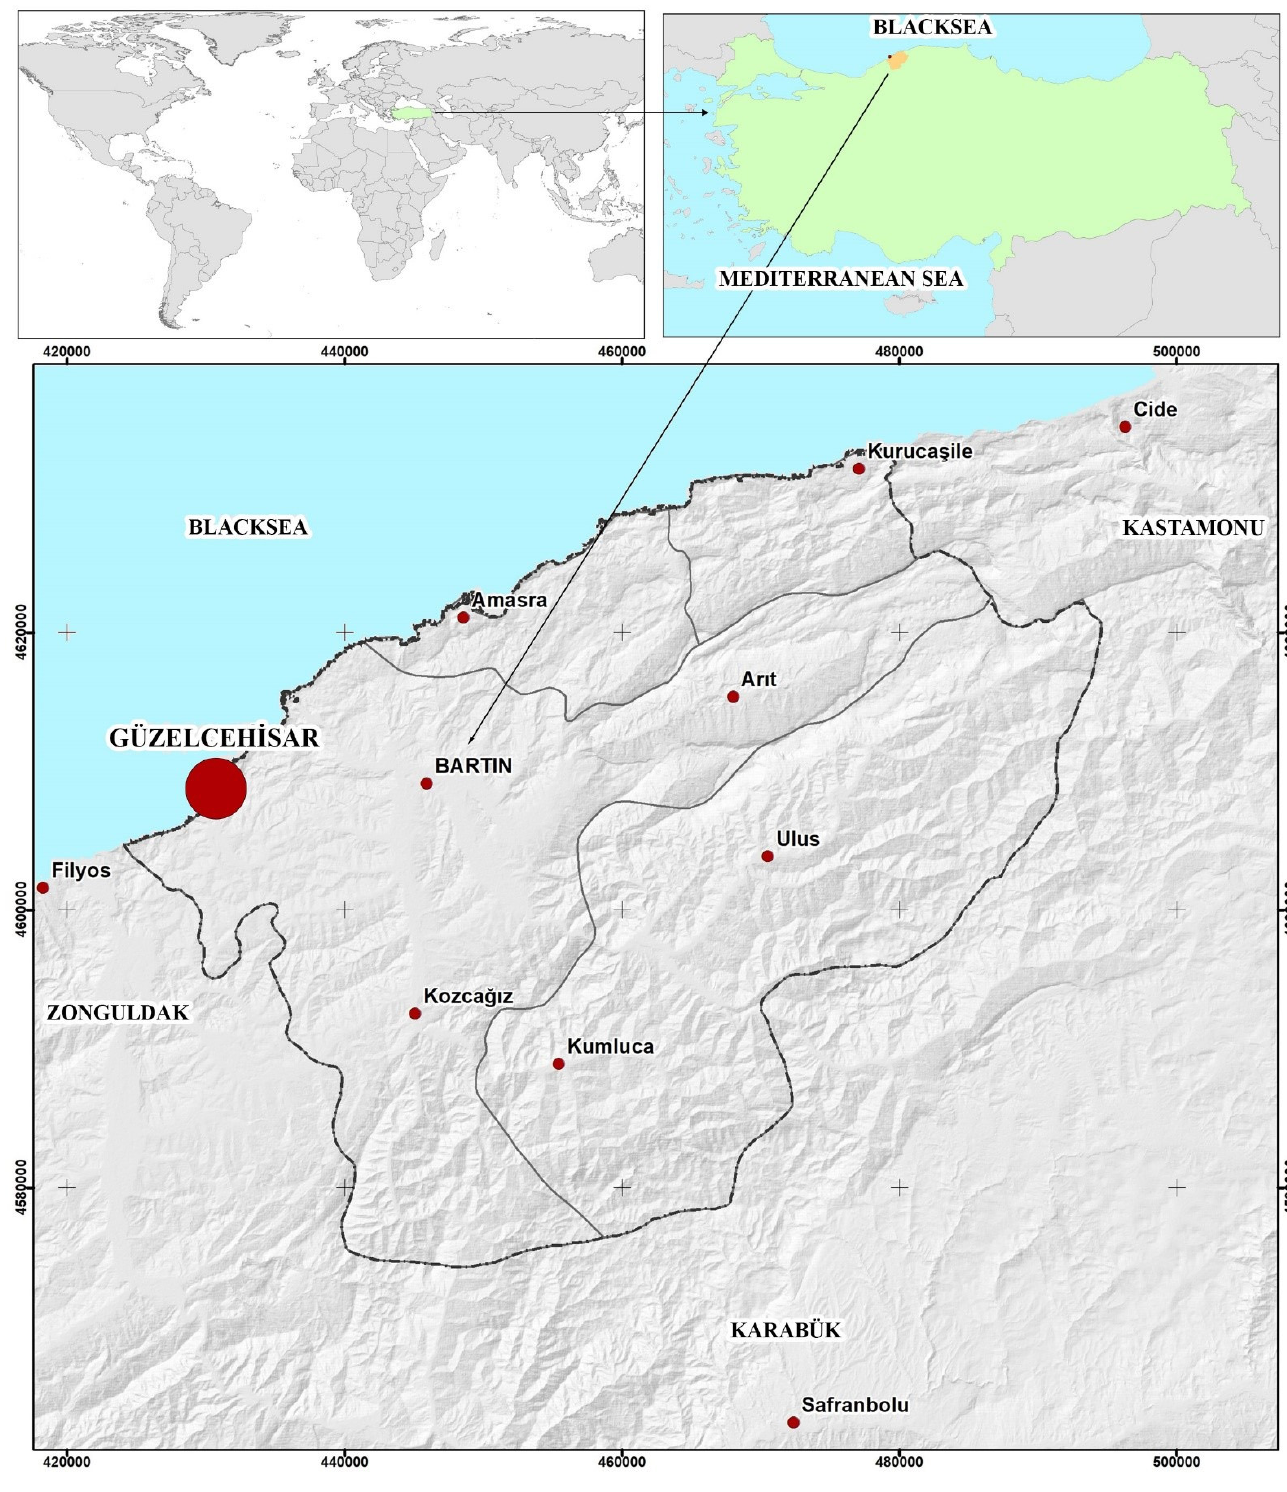
Figure 1. Location of the research